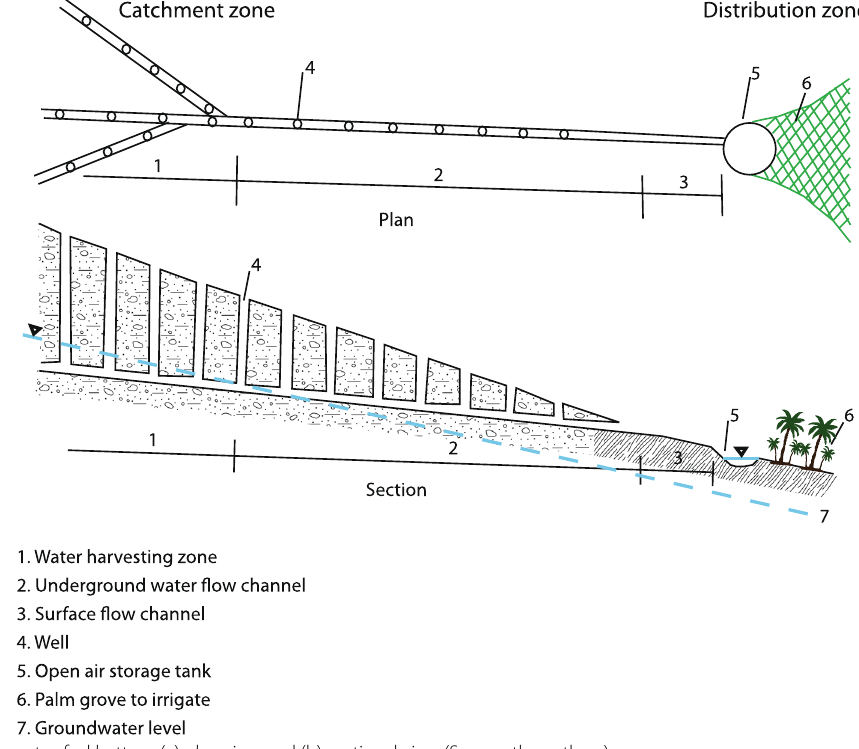
Fig. 3 The components of a khettara, (a) plan view and (b) sectional view (Source: the